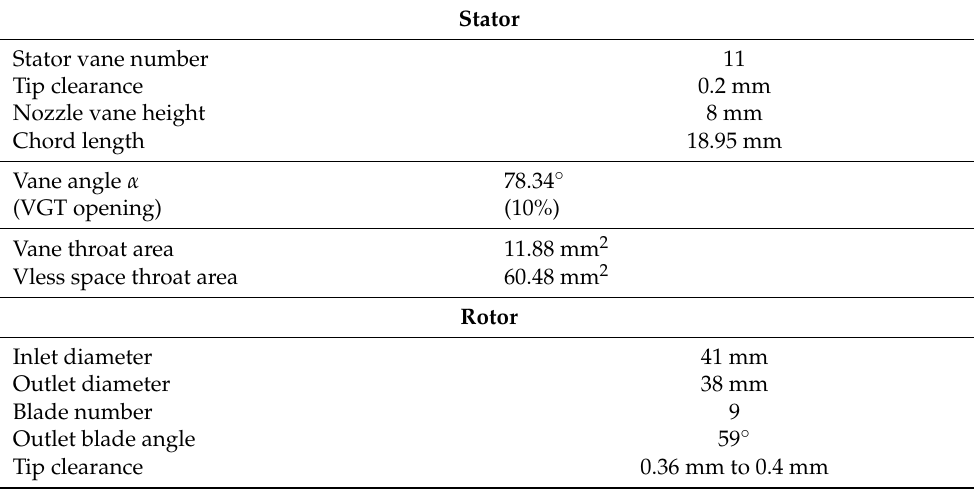
Table 1. Geometrical characteristics of the